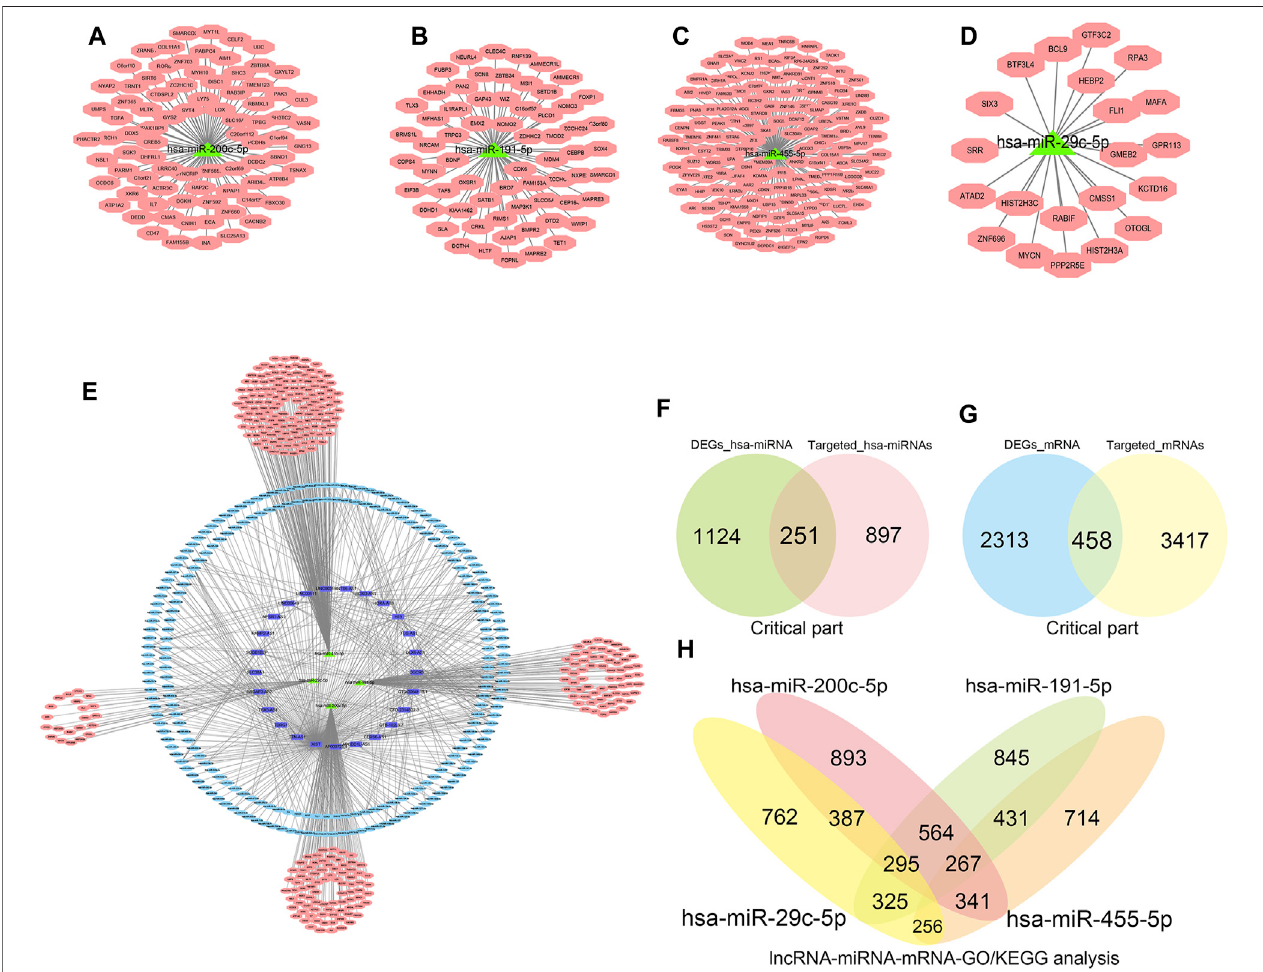
FIGURE 7 | Construction of competing endogenous RNA network interactions based on differential micro RNA (miRNA)-messenger RNA (mRNA), long non- coding RNA (lncRNA)-miRNA, and long non-coding RNA-messenger RNA. The results of miRNA prediction combined with mRNA for network interaction analysis ( Figures 7A – D ); the results of lncRNA-miRNA-mRNA network interactions are shown ( Figure 7E ); the intersection results of predicted mRNA, miRNA with differential miRNA, and mRNA, respectively ( Figures 7F, G ). The key miRNA-mRNAs were screened for downstream pathway analysis and prediction ( Figure 7H ).